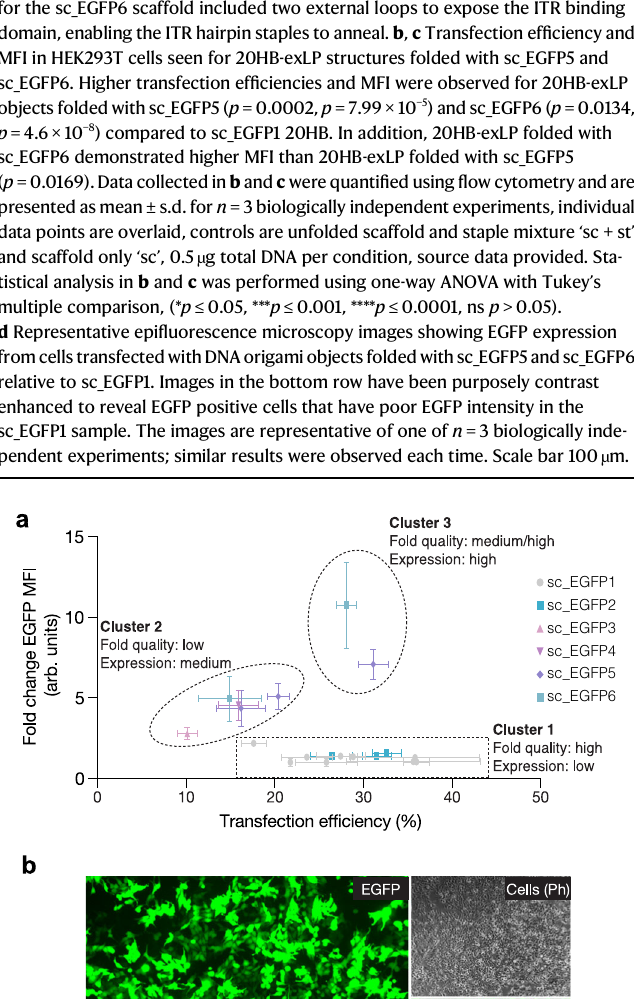
Fig. 5 | Transfection summary and optimization. a Comparison summary of transfection ef fi ciency (%) and EGFP MFI (arb. units) across all structures investi- gated in HEK293T cells, grouped by scaffold. sc_EGFP1 20HB-ext was used as an internal control in all experiments, and EGFP MFI is represented as fold change compared to this sample. For each sample n ≥ 3 biologically independent experi- ments, and is represented as mean ± s.d, source data provided. Three clusters are highlighted:1,structureswithhighfolding qualitybutlowoverallgeneexpression; 2, structures with low folding quality and medium expression levels; 3, structures with medium to high folding quality and high expression levels. b Representative epi fl uorescent microscopy images showing the expression of EGFPbysuccessfully transfected HEK293T cells after optimization of electroporation settings, where EGFP expression (green), cell (phase contrast) and the overlay are given. The images are representative of one of n =2 biologically independent experiments; similar results were observed each time. Scale bar 100 µ